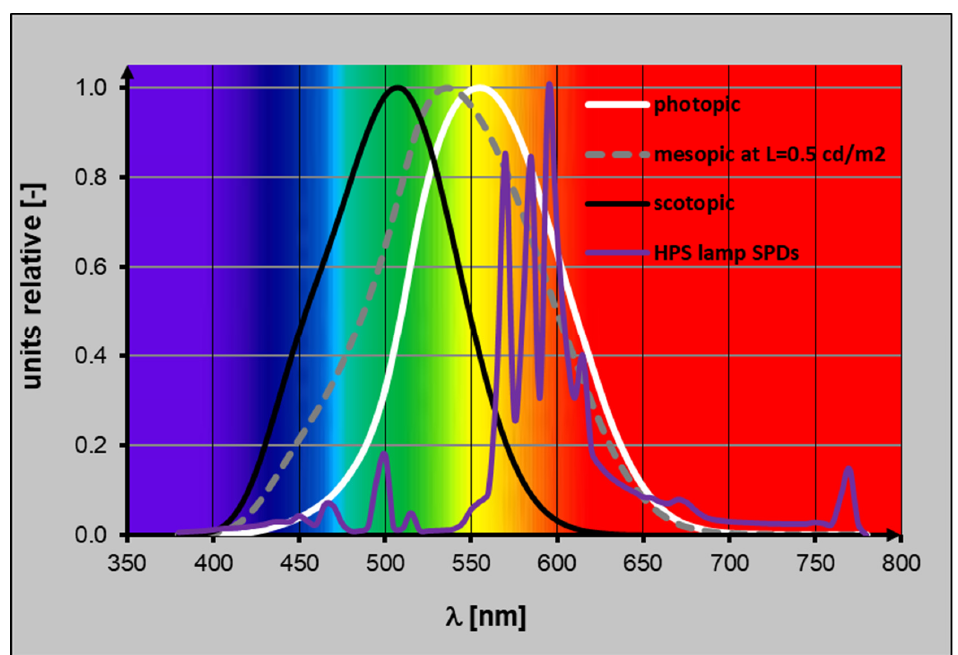
Figure 1. Spectral luminous efficiency of the human eye under photopic (white curve), scotopic (black curve), and mesopic (grey curve) vision conditions at luminance level L = 0.5 cd/m 2 obtained with high-pressure sodium (HPS) lamp (spectral distribution of radiant power (SPDS) of HPS lamp ( CCT = 2060 K) is show as violet curve).